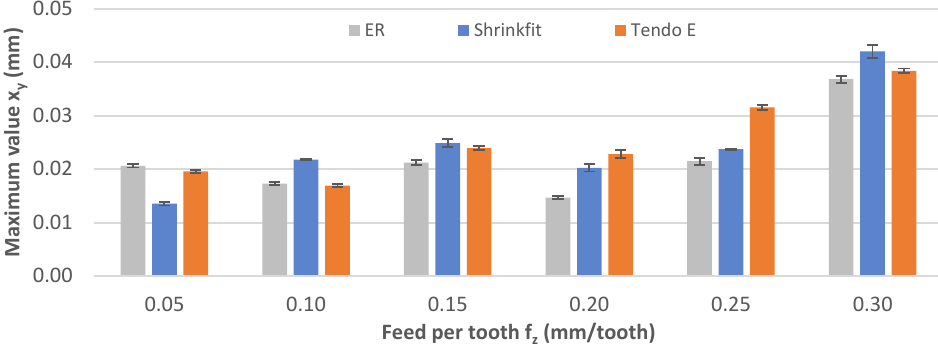
Figure 9. Impact of feed per tooth f z on maximum vibration displacement value x y (v c = 800 m/min, a p = 6 mm). Increasing the feed per tooth to f z = 0.10 mm/tooth resulted in a vibration displace- ment value decrease, while further ranges were associated with a continuous increase. While carrying out the milling process, the recorded values were 0.014–0.042 mm, with the lowest feed per tooth values of f z = 0.15–0.30 mm/tooth for the ER collet chuck, f z = 0.05 mm/tooth for the heat shrink chuck, and f z = 0.10 mm/tooth for the Tendo E hydraulic chuck.